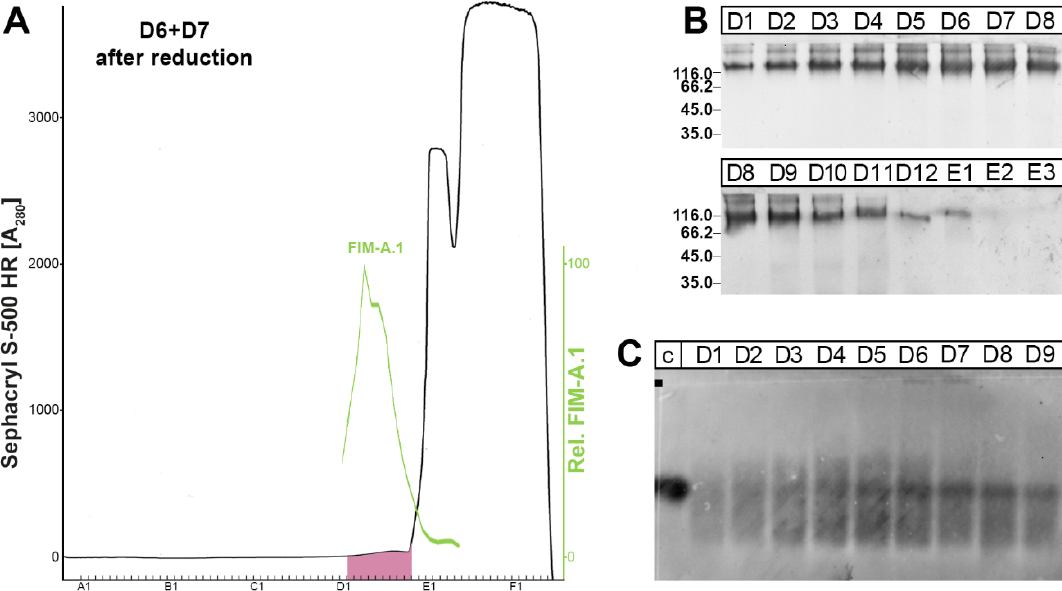
Figure 3. Analysis of X. laevis FIM-A.1 by SEC after reduction. Fractions D6 + D7 (1.5 mL each) from SEC of Figure 2 were reduced in boiling 4.7% β -mercaptoethanol/0.1% SDS and separated immediately thereafter by SEC on an S-500 column. ( A ) Elution profile as determined by absorbance at 280 nm (PAS-positive mucin fractions: pink). Relative FIM-A.1 content (green), as determined by Western blot analysis under reducing conditions and semi-quantitative analysis of the characteristic ≥ 116,000 band (anti-FIMA-1). ( B ) 15% SDS-PAGE under non-reducing conditions and Western blot analysis of fractions D1–E3 using anti-FIMA-1. ( C ) 1% AgGE of fractions D1–D9 and Western blot analysis using anti-FIMA-1; for comparison ( C ): fraction D7 from Figure 2 (S-500 before reduction).